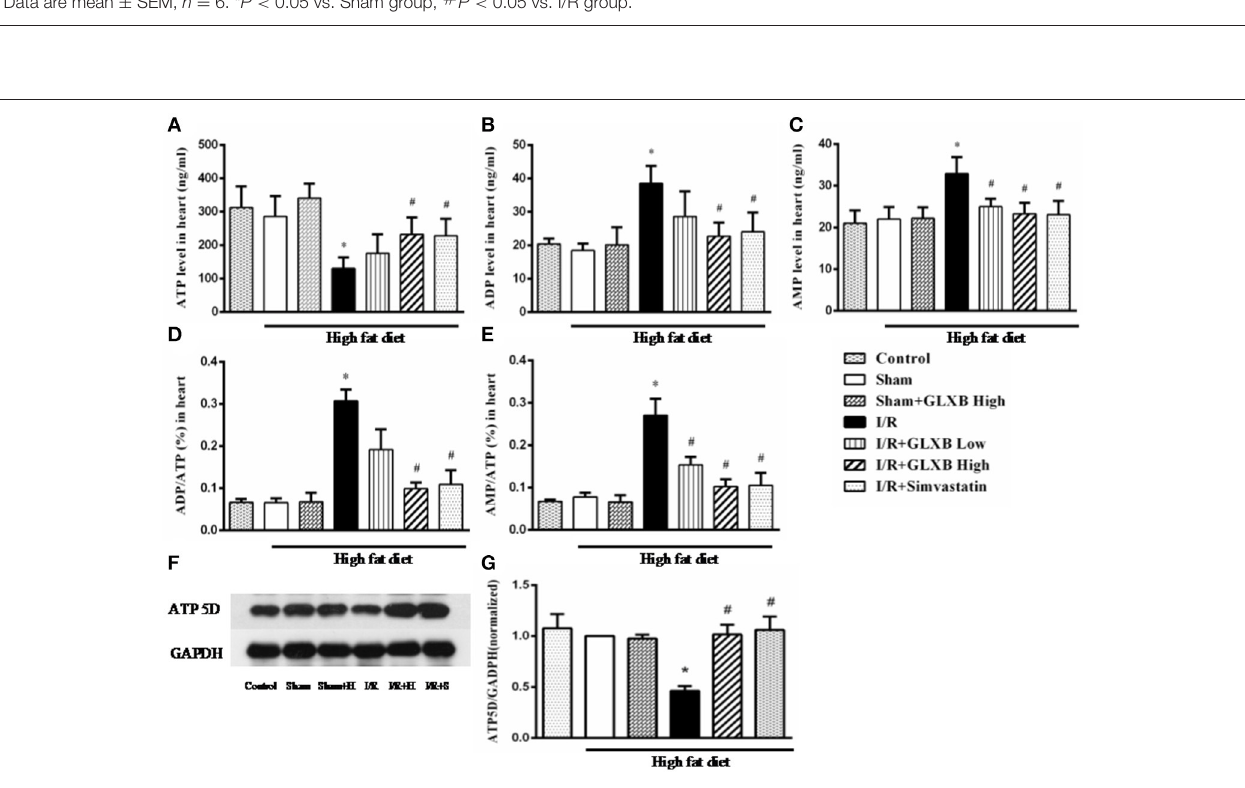
FIGURE 6 | The effect of GLXB on the level of AMP, ADP and ATP in myocardial tissue of rats. (A) The content of ATP in myocardial tissues in different groups. (B) The content of ADP in myocardial tissues in different groups. (C) The content of AMP in myocardial tissues in different groups. (D) The ratio of ADP/ATP in myocardial tissues in different groups. (E) The ratio of AMP/ATP in myocardial tissues in different groups. Data are mean ± SEM, n = 6. * P < 0.05 vs. Sham group, # P < 0.05 vs. I/R group. (F) Representative Western blotting bands of ATP 5D in various groups. (G) The semi-quantitative analysis of ATP 5D in various groups. Data are mean ± SEM, n = 6. * P < 0.05 vs. Sham group, # P < 0.05 vs. I/R group.